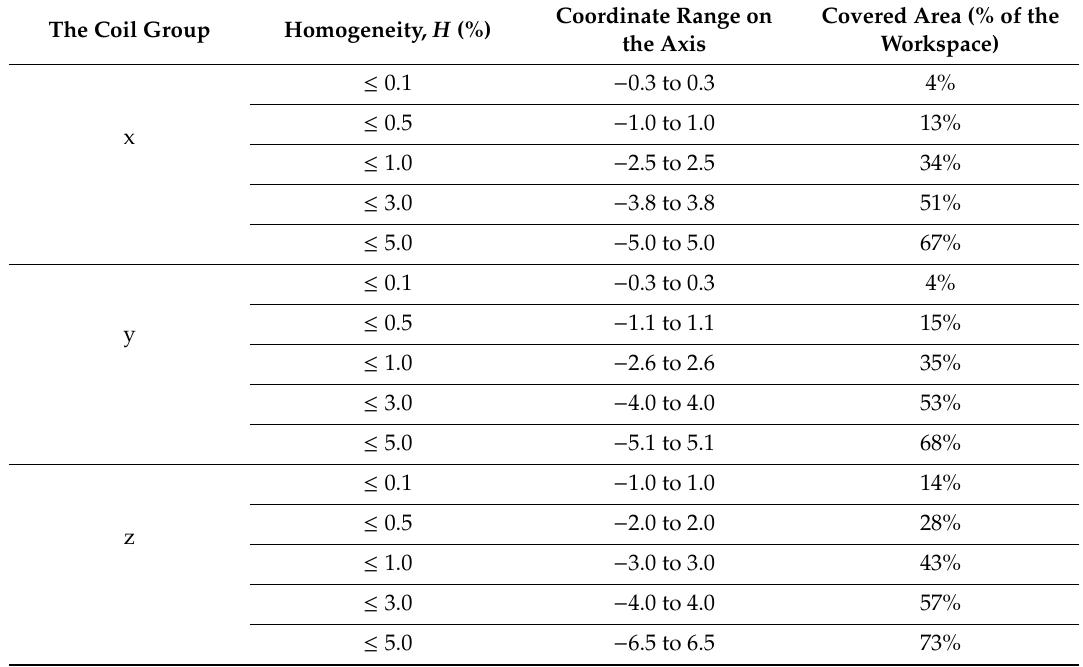
Table 1. Homogeneity of the